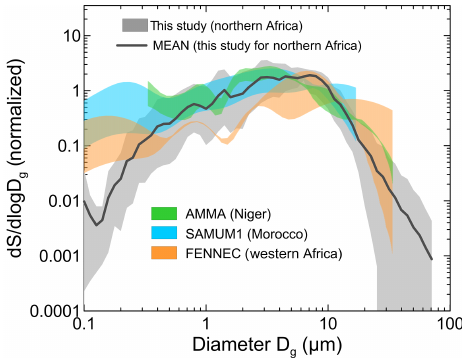
Figure 6. Comparison of CESAM measurements at the peak of the injection with dust size distributions from several airborne field campaigns in northern Africa. The grey shaded area represents the range of sizes measured in CESAM during experiments with the different northern African samples. Data from field campaigns are: AMMA (Formenti et al., 2011), SAMUM-1 (Weinzierl et al., 2009), and FENNEC (Ryder et al., 2013a). The shaded areas for each dataset correspond to the range of variability observed for the cam- paigns